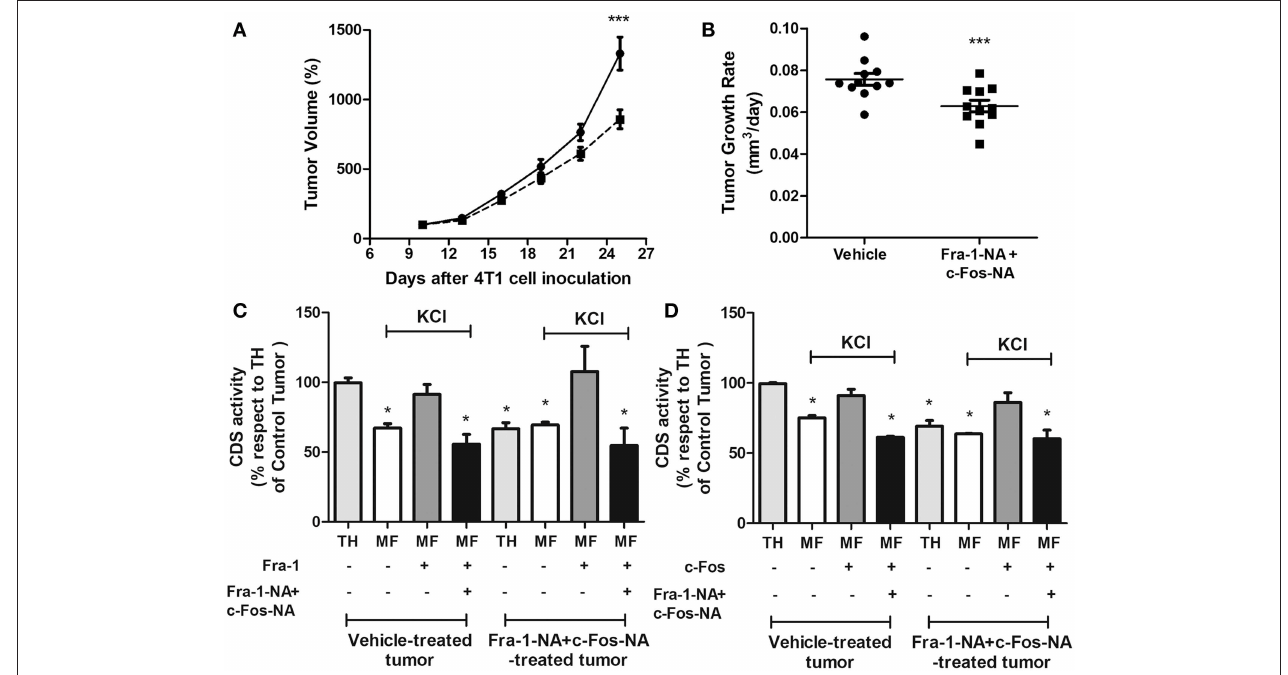
FIGURE 7 | When grown in the same animal, Fra-1-NA + c-Fos-NA treatment impairs tumor growth and CDS activity. Mice bearing two tumors received intratumoral injections of liposomes containing equal concentrations of Fra1-NA plus c-Fos-NA into one tumor and empty liposomes into the other. Peptide administered: 5 injections containing a total of 9 nmol of Fra-1-NA plus c-Fos-NA peptides per injection (dashed line) or vehicle (continuous line) delivered three times a week for 15 days. (A) Tumor volumes were measured at 3-day intervals during the treatment period. Results are expressed as the percent volume taking the volume of the tumor at 10 days of inoculation as 100%. *** p < 0.001 (Two-way ANOVA, Bonferroni post-test) (B) Tumor growth rates were calculated for each group at the end of the treatment as the slope of the curve obtained by plotting the log 10 of the tumor volume in function of the days of treatment. Horizontal bars represent mean values. *** p < 0.001 (Paired t -test). Mice examined: n = 11. (C,D) CDS activity was measured in TH (light gray bars) and the microsomal fraction (MF) stripped with KCl 1M (white, dark gray and black bars) from vehicle-treated tumors and Fra-1-NA plus c-Fos-NA-treated tumors of two mice. Recombinant wild type Fra-1 (C) ,